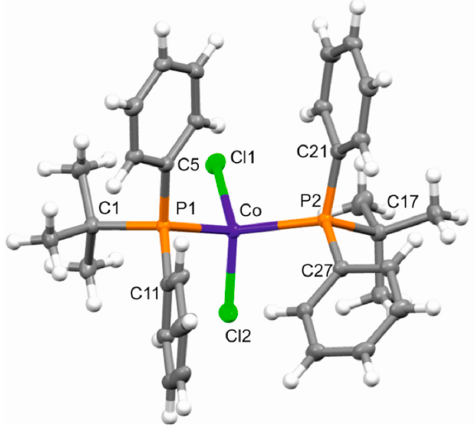
Figure 2. Molecular structure of 1 with thermal ellipsoids drawn at 50% probability level.